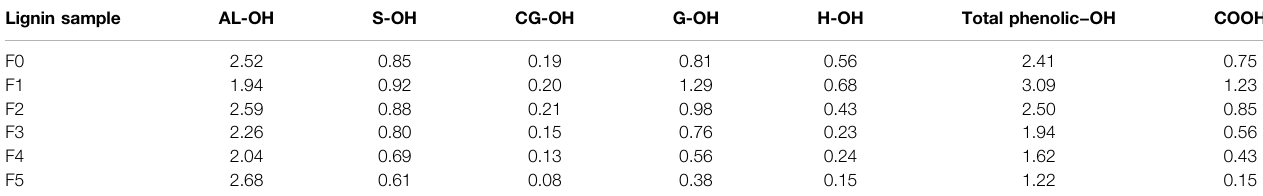
TABLE 2 | Quanti fi cation of the lignin samples by quantitative 31 P-NMR Method (mmol/g). Lignin sample